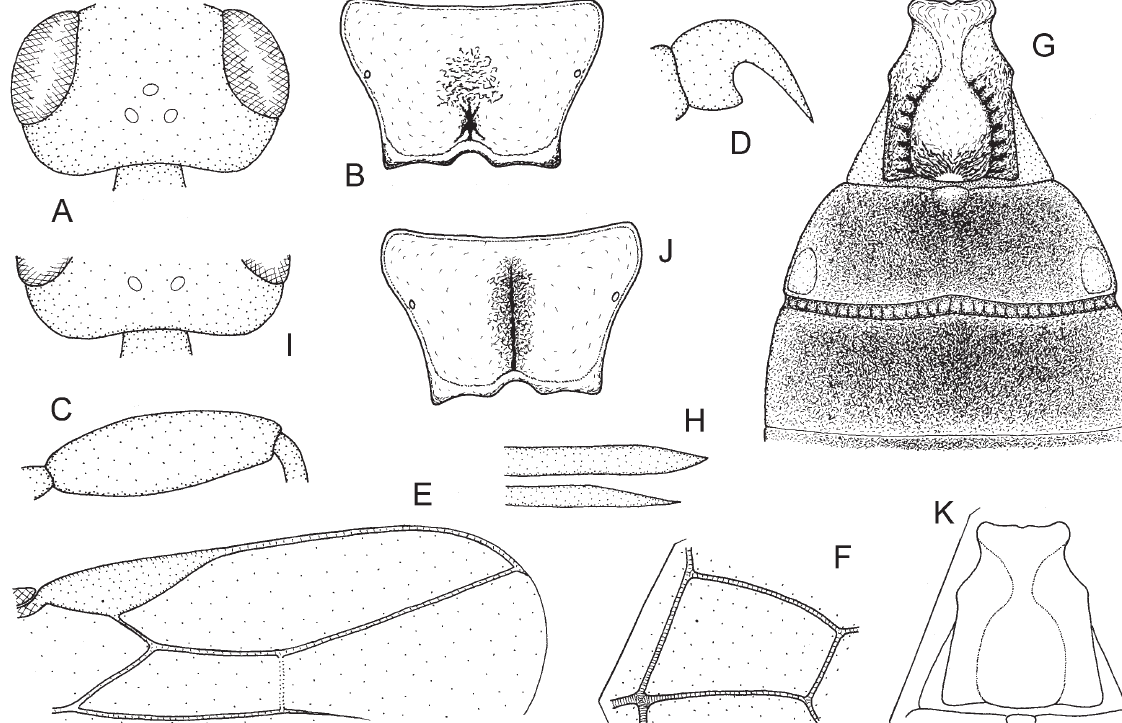
Fig. 47. Bracon ( Bracon ) tenuicornis Wesmael, 1838 (A-H: ♀ holotype, I-K: ♀). A . Head in dorsal view. B . Propodeum. C . Hind femur. D . Claw. E . Distal part of right forewing. F . First discal cell of right forewing. G . Tergites 1-3. H . Posterior end of ovipositor apparatus. I . Hind half of head in dorsal view. J . Propodeum. K . First